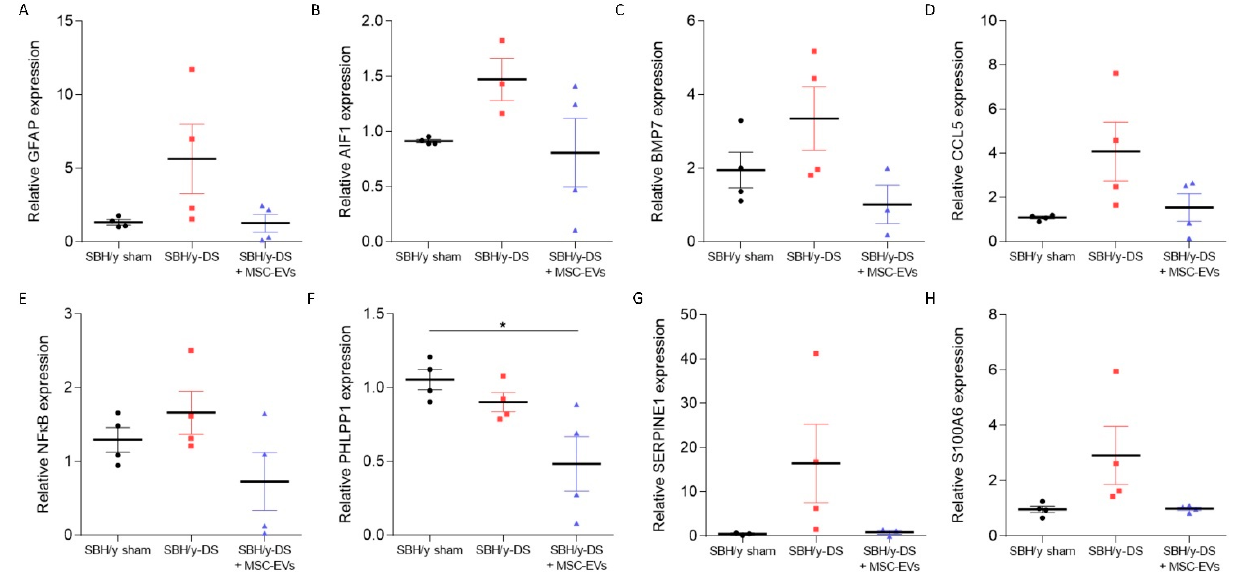
Figure 5. mRNA alternations between SBH/y sham, SBH/y-DS, and mesenchymal stem cell-derived extracellular vesicle- (MSC-EV) treated SBH/y-DS rats. mRNA expression analysis of Gfap ( A ), Aif1 ( B ), Bmp7 ( C ), Ccl5 ( D ), Nf κ b ( E ), Phlpp1 ( F ), Serpine1 ( G ), and S100a6 ( H ) in rats’ cortices ( n = 4)